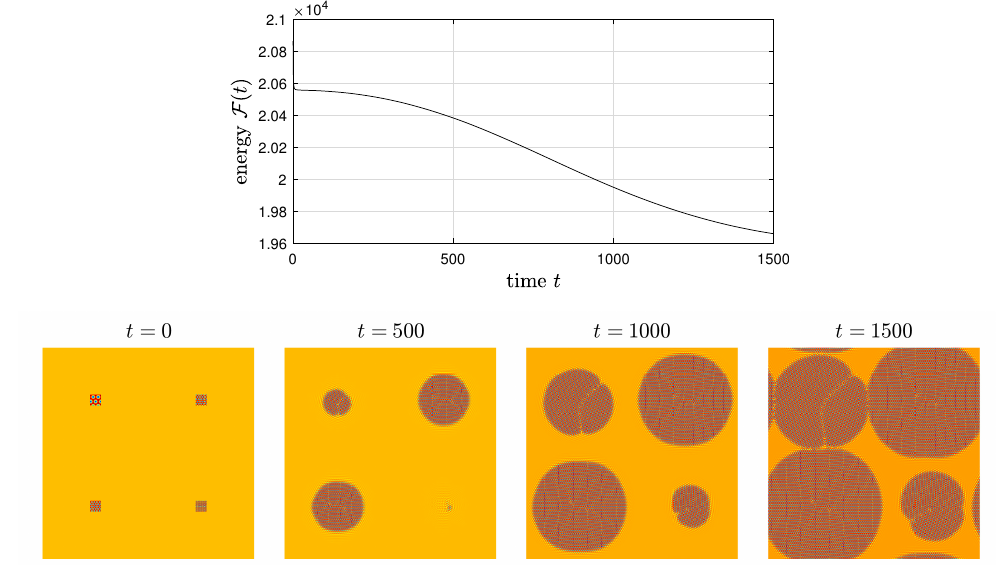
Figure 5. Evolution of F ( t ) and φ ( x , y , t ) with (cid:101) = 0.25, ∆ x = ∆ y = 1, and ∆ t = 1. The red, green, and blue regions show φ = 0.6475, 0.0741, and − 0.4993,